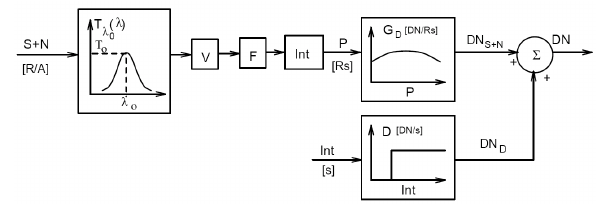
Fig. A1. Block diagram of linear system representing the relation- ship between incoming photon flux ( S + N ) and corresponding data Figure A.1 . Block diagram of linear system representing the relationship between incoming photon flux ( S + N ) and corresponding data number.